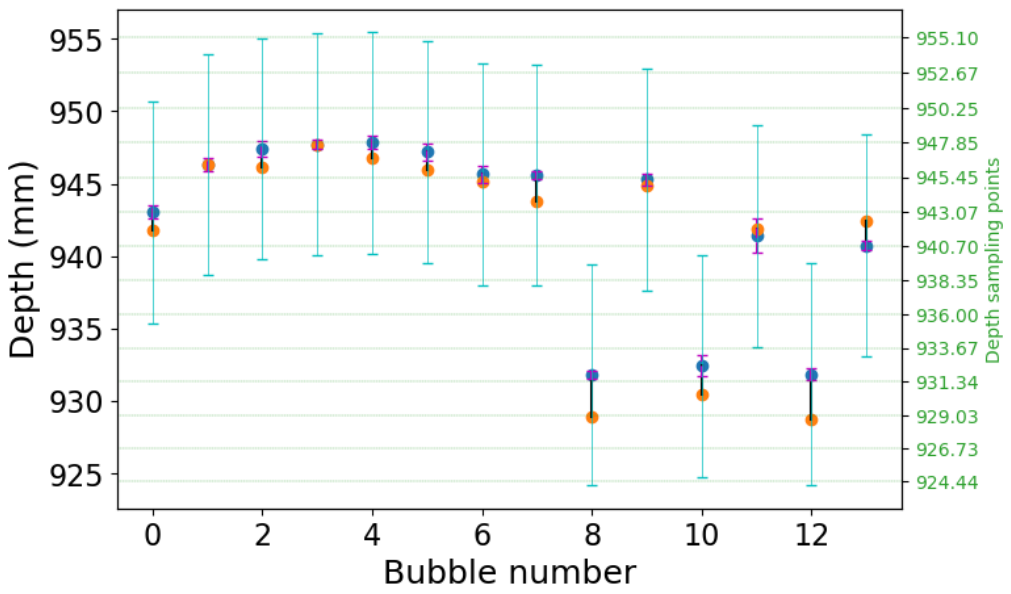
Figure 7. Performance evaluation of the depth-estimation of the light-field acquisition (Figure 6d) against the tomographic acquisition (Figure 6c). For the 13 largest bubbles, the blue dots indicate the expected depth for the center of the bubbles, while the orange dots indicate the reconstructed depth. The magenta bars indicate the bubble size, and the cyan bars indicate the expected uncertainty from the limited angle. The green horizontal dashed lines indicate the depths sampling used for the creation of the focal stack. The corresponding depths are indicated on the right